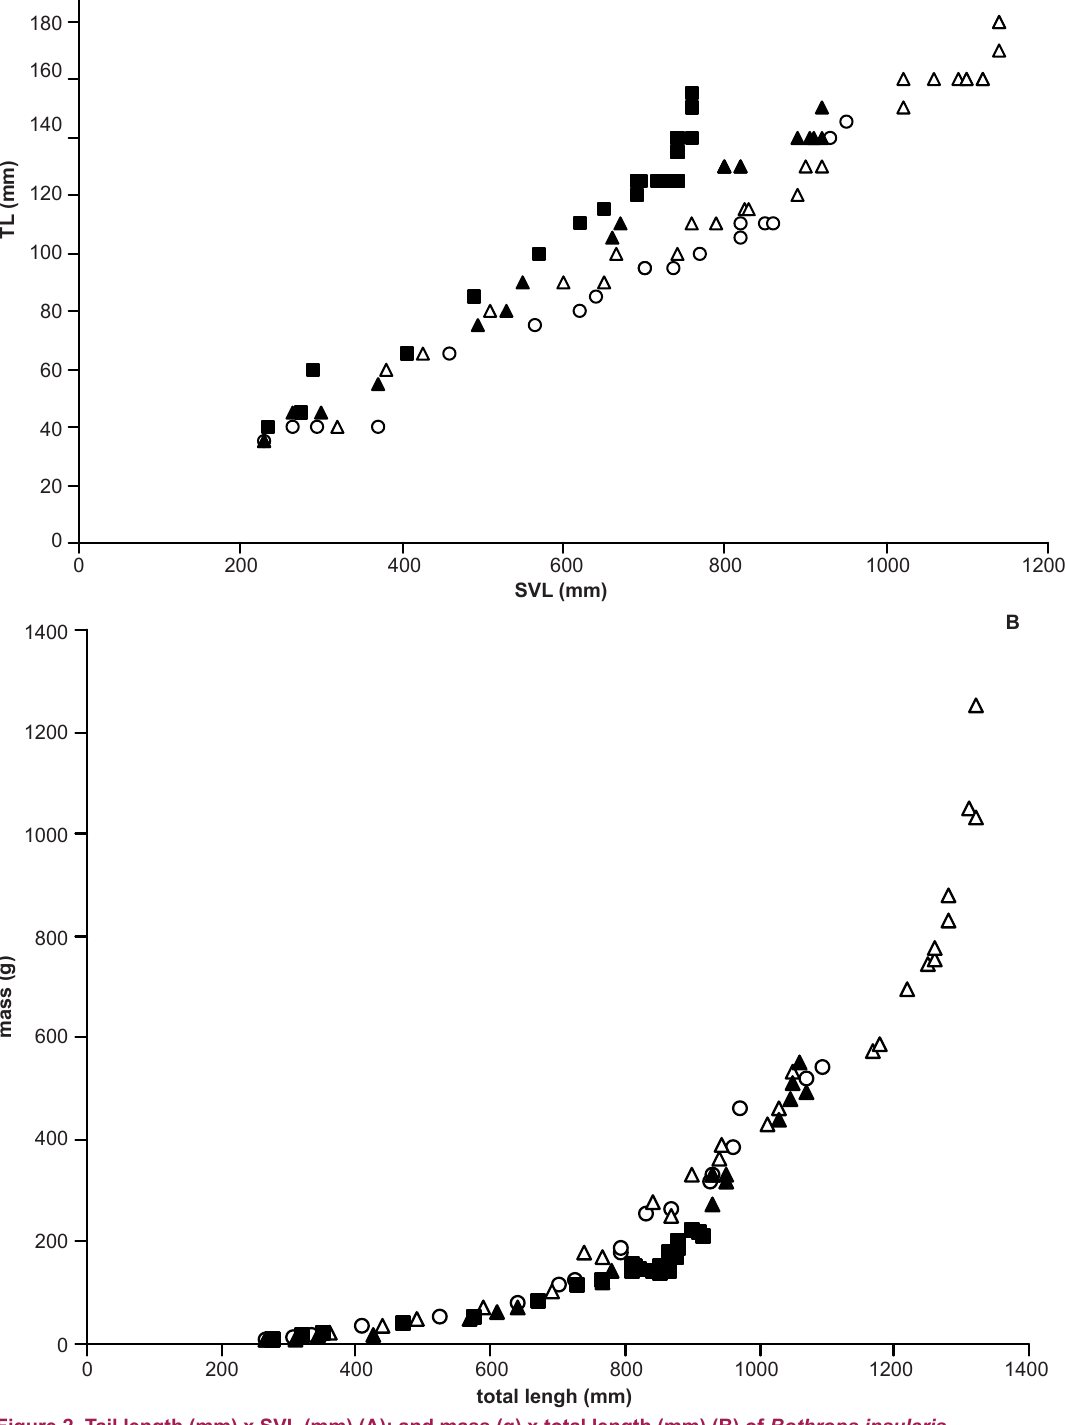
Figure 2. Tail length (mm) x SVL (mm) (A); and mass (g) x total length (mm) (B) of Bothrops